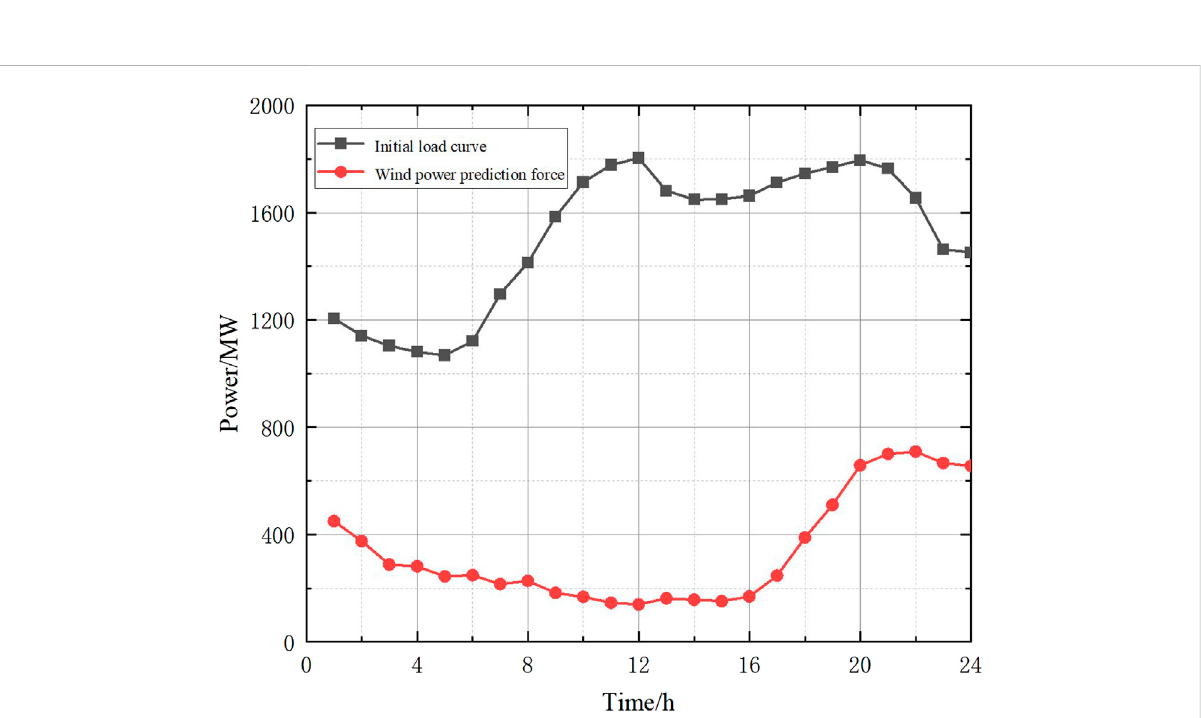
FIGURE 6 Wind power forecast output and typical daily load